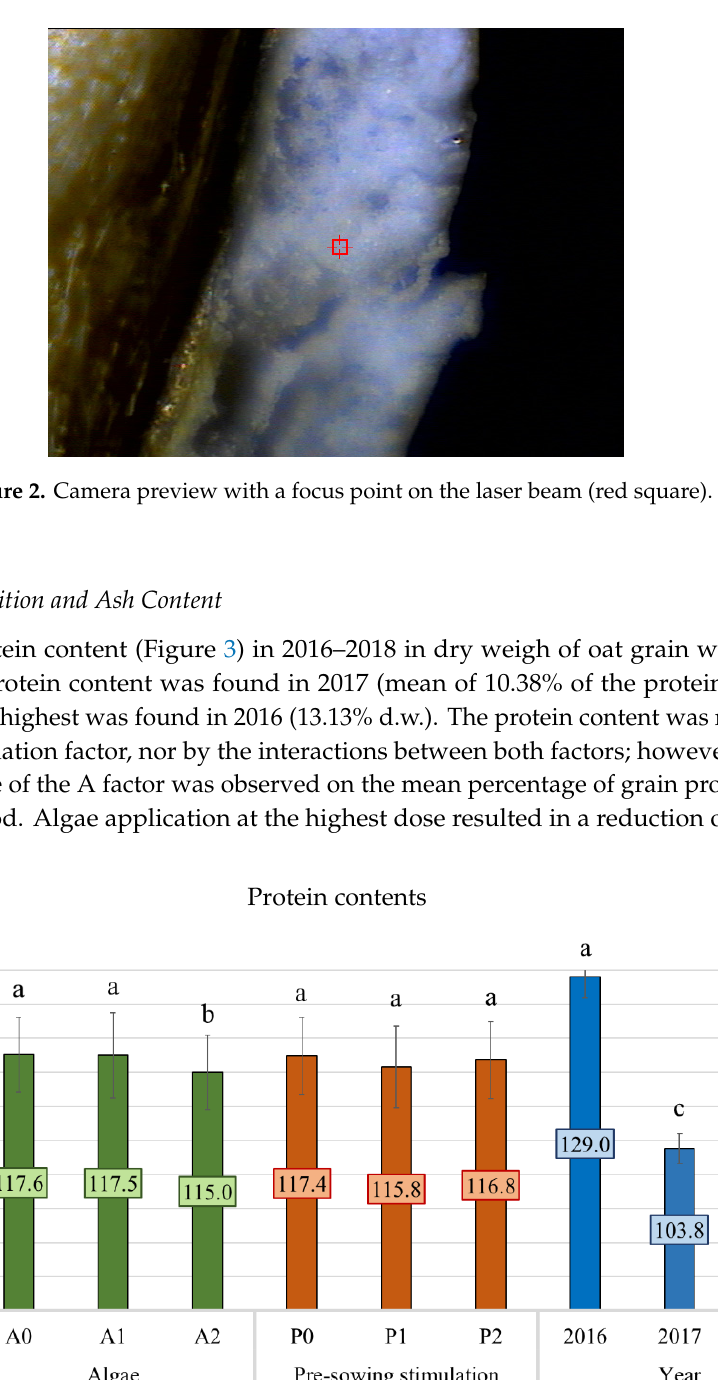
Figure 4. The mean crude fat content of protein in oat grains in 2016–2018, depending on the experimental factors used. According to Tukey’s HSD test, means marked with the same letter are not significantly different at α ≤ 0.05. The content of raw fiber in dry weight (Figure 5) of oat grain was on average 118.3 g ⋅ kg −1 (11.83% d.w.). Its highest content was recorded in 2018 (12.14% d.w.), the lowest in 2016 (11.28%). The content of raw fiber in the grain was not differentiated by the experimental factors; however, it was statistically significantly differentiated in the yearly results.